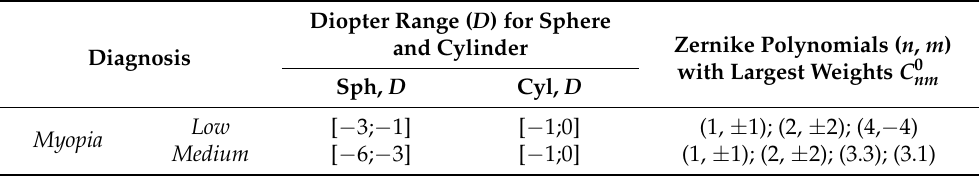
Table 2. Correspondence of the diagnosis, range of diopter values for spheres and cylinders, and Zernike polynomials with the largest weight